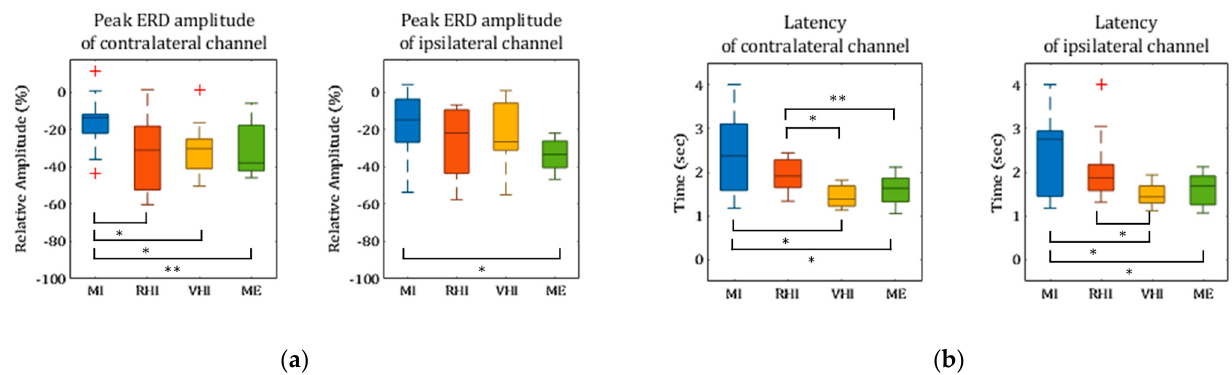
Figure 5. Findings in the contralateral and ipsilateral channel: ( a ) peak event-related desynchronization (ERD) amplitude and ( b ) latency. (The asterisks indicate significant differences, * p < 0.05, ** p < 0.01). Table 1. Statistical analysis for the contralateral and ipsilateral channel. Friedman test and Wilcoxon signed rank test between paradigms (asterisks indicate significant differences, * p < 0.05, ** p < 0.01). Friedman